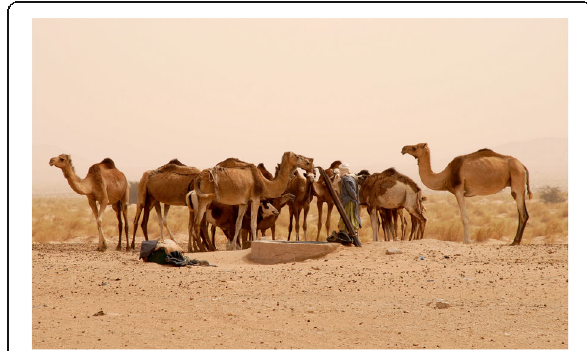
Figure 12 Camel herd at a Western Sahara well with roughly 30% of piebald camels